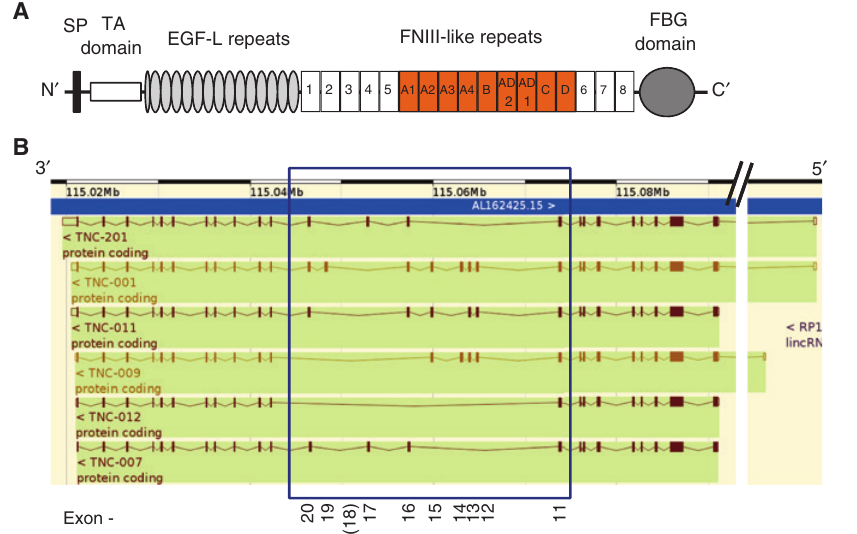
Figure 2: Alternative splicing of the human tenascin-C gene ( TNC ) and associated protein domains. (A) At the protein level, each tenascin-C monomer consists of a signal peptide targeting the protein for secretion (SP), an N terminal tenas- cin assembly (TA) domain responsible for hexamer formation and a run of 14.5 epidermal growth factor-like (EGF-L) repeats. Towards the C-terminus are between 8 and 17 fibronectin type III-Like (FNIII) repeats, and the number of repeats is determined by alternative splicing; plus a C-terminal Fibrinogen-Like Globe (FBG) domain. The FNIII repeats shown in white are expressed in all variants, while the orange